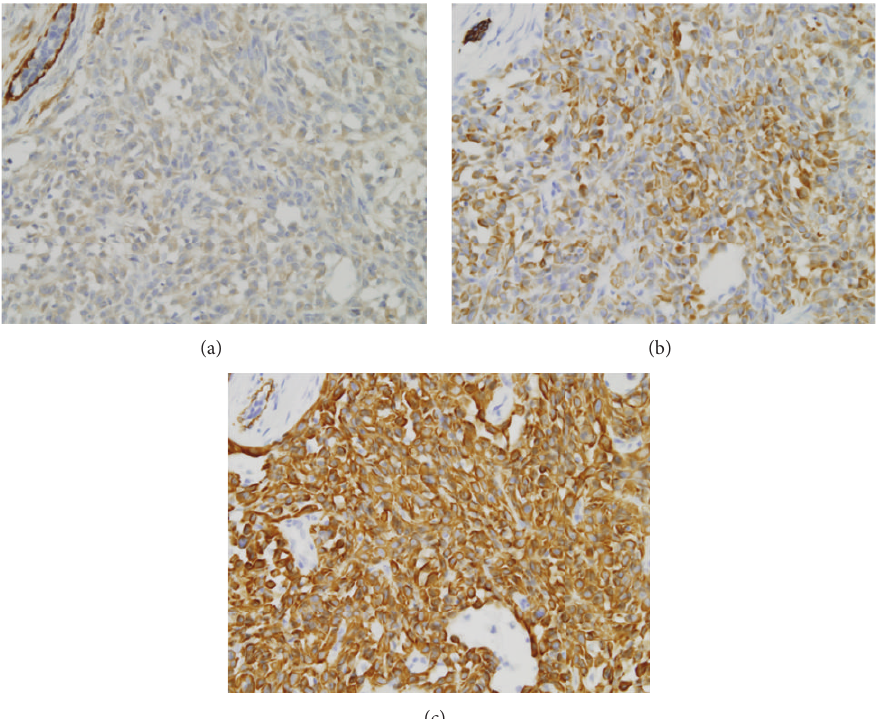
Figure 2: (a) Myoepithelial carcinoma revealed a diffuse cytoplasmic positivity for cytokeratin AE1/AE3 (immunohistochemical stain, × 200). (b) Cells showing calponin positivity (immunohistochemical stain, × 200). (c) Cells showing CK14 positivity (immunohistochemical stain, ×